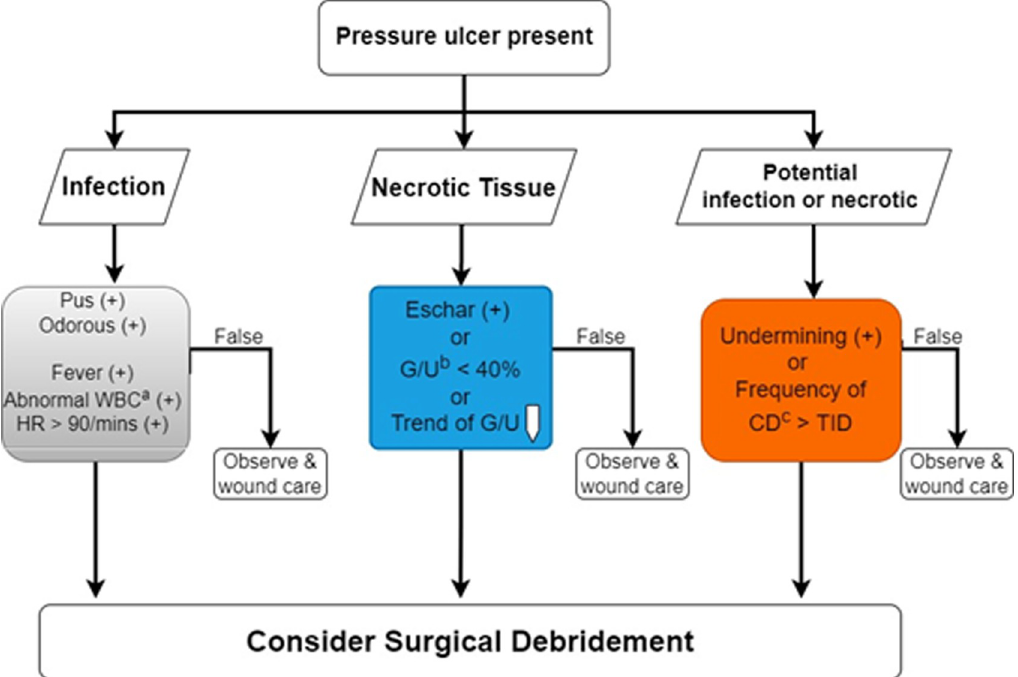
Fig 7. Decision tree of surgical debridement. Combining the DL segmentation result (blue) with clinical data (grey) and other wound conditions (grey and orange). a Abnormal WBC": white blood cell count > > 12,000 / mm^3. b G/U: Granulation / Ulceration Area. c CD: Change